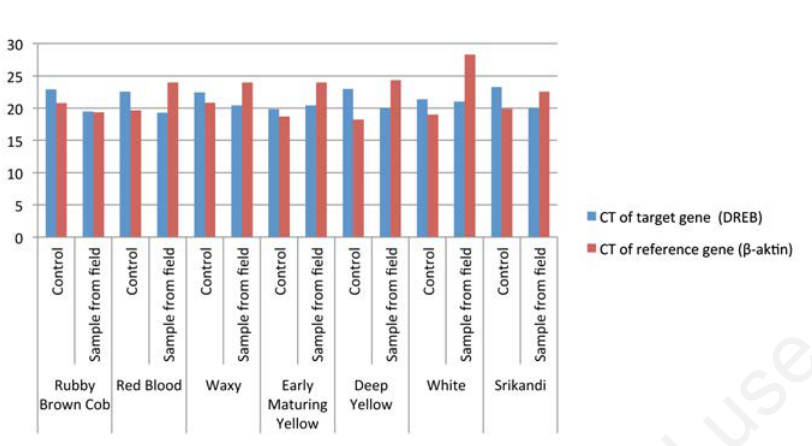
Figure 3. Cycle threshold value of target and reference gene from corn cultivars (control and sample from the field) resulting from real time polymerase chain